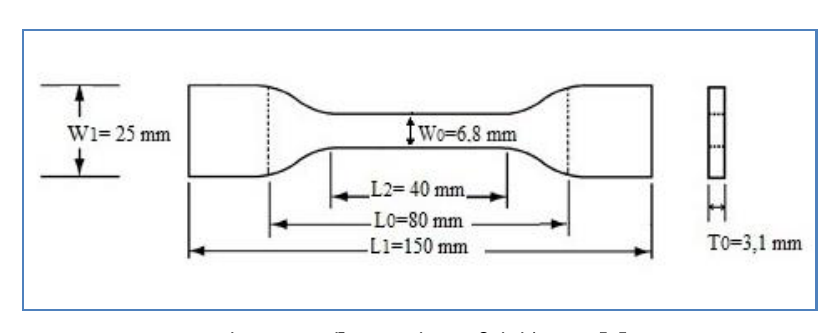
Fig. 1. Tensile test piece of rigid PVC